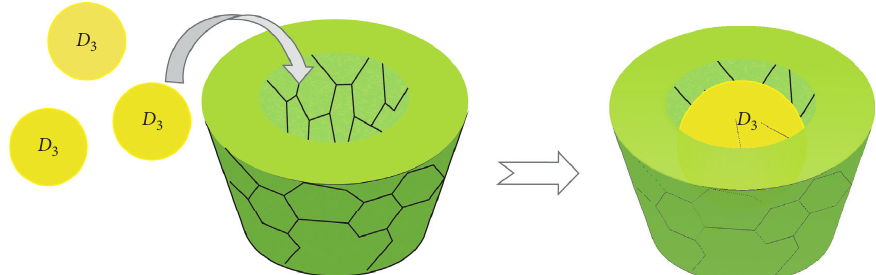
Figure 2: Schematic representation of the “guest-host” inclusion complex